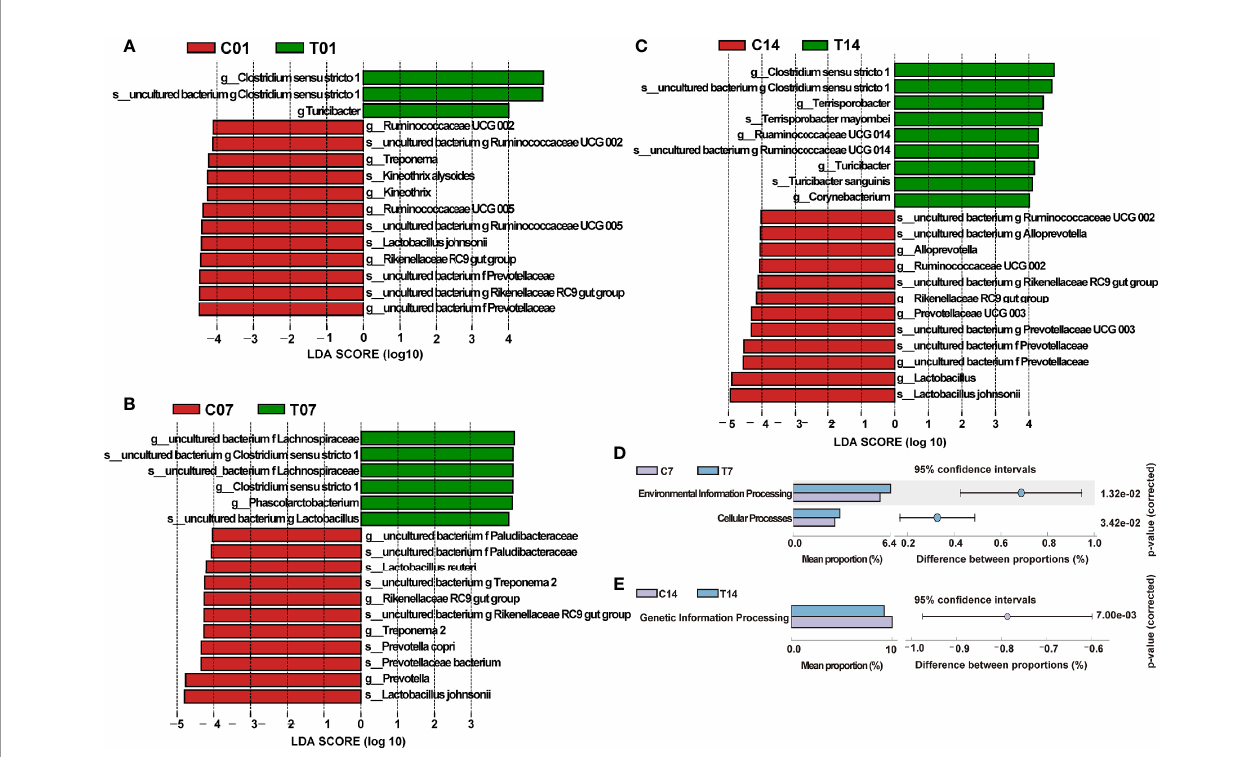
FIGURE 8 | Effect of HS on the difference in microbial composition of pig colon. CON and C indicate no heat stress group, HS and T indicate heat stress treatment, 1, 7, 14, 21 indicate day 1, 7, 14, and 21 groups respectively; (A) LEfSe analysis between C01 and T01 groups; (B) LEfSe analysis between C07 and T07 groups; (C) LEfSe analysis between C14 and T14 groups; (D, E) KEGG metabolism prediction differences between groups in day 7 and 14 of